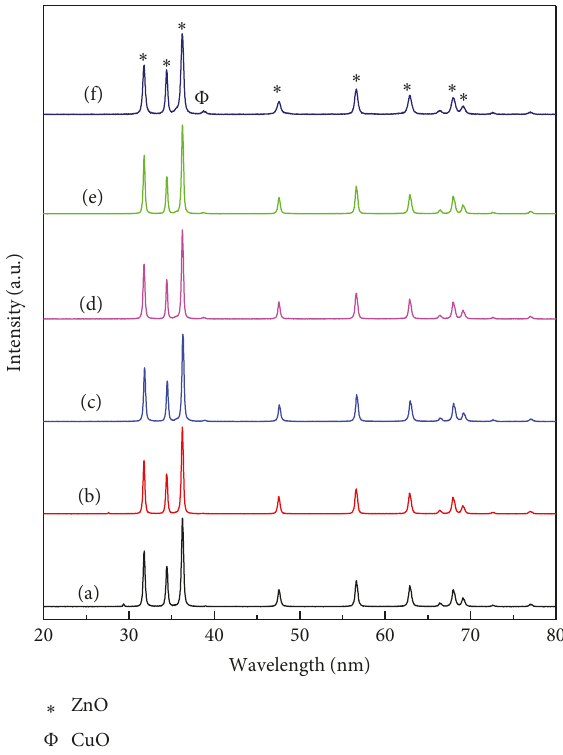
Figure 1: XRD diffraction patterns of (a) ZnO, (b) Cu-ZnO (1%), (c) Cu-ZnO (2%), (d) Cu-ZnO (3%), (e) Cu-ZnO (4%), and (f) Cu- ZnO